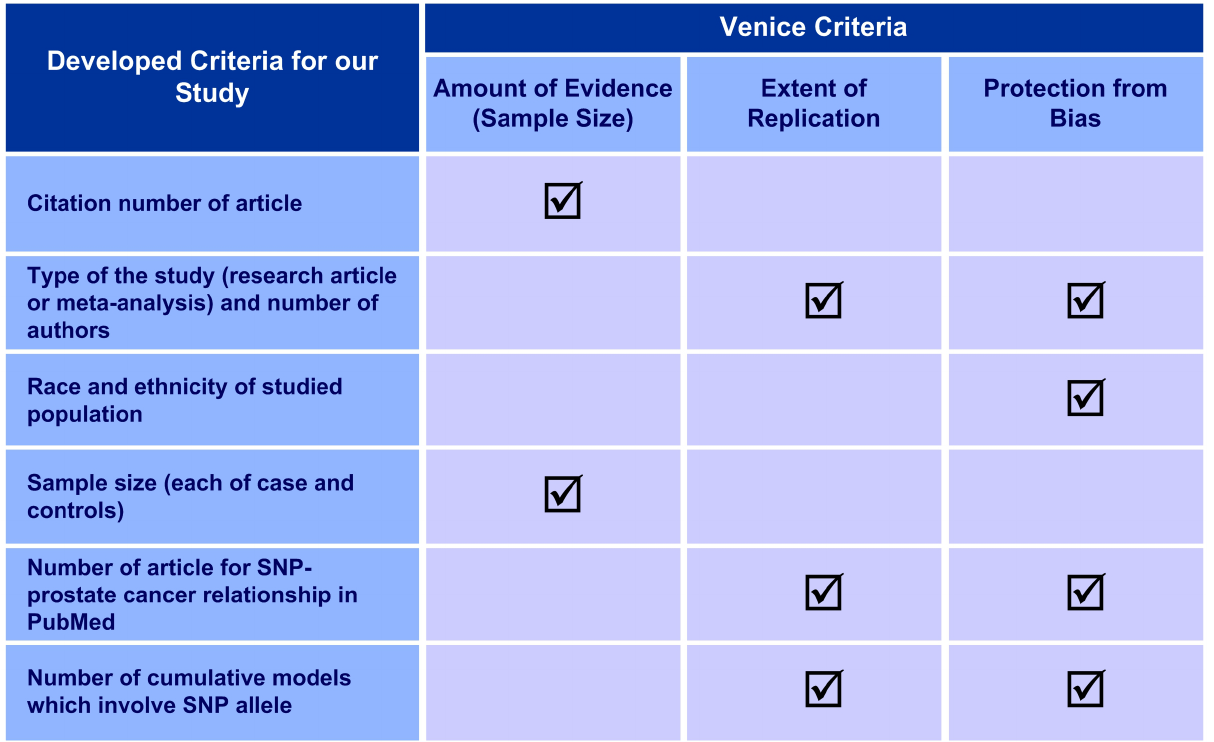
Figure 2. Matching of our parameters and Venice criteria. SNP=single nucleotide